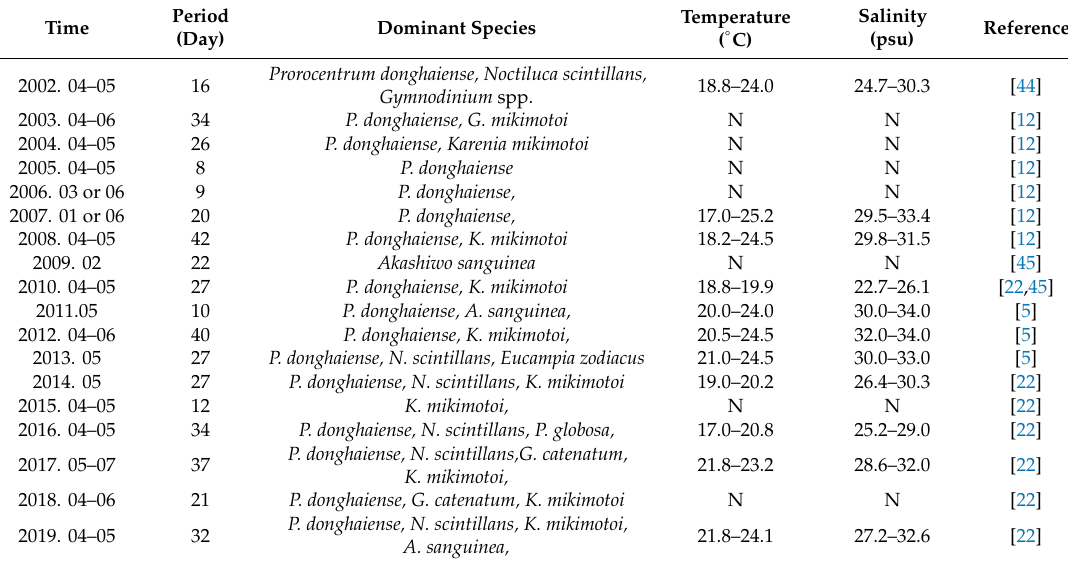
Table 2. Summary of dinoflagellate blooms in Fujian coastal water during 2002 to 2019. “N” indicates that no data was